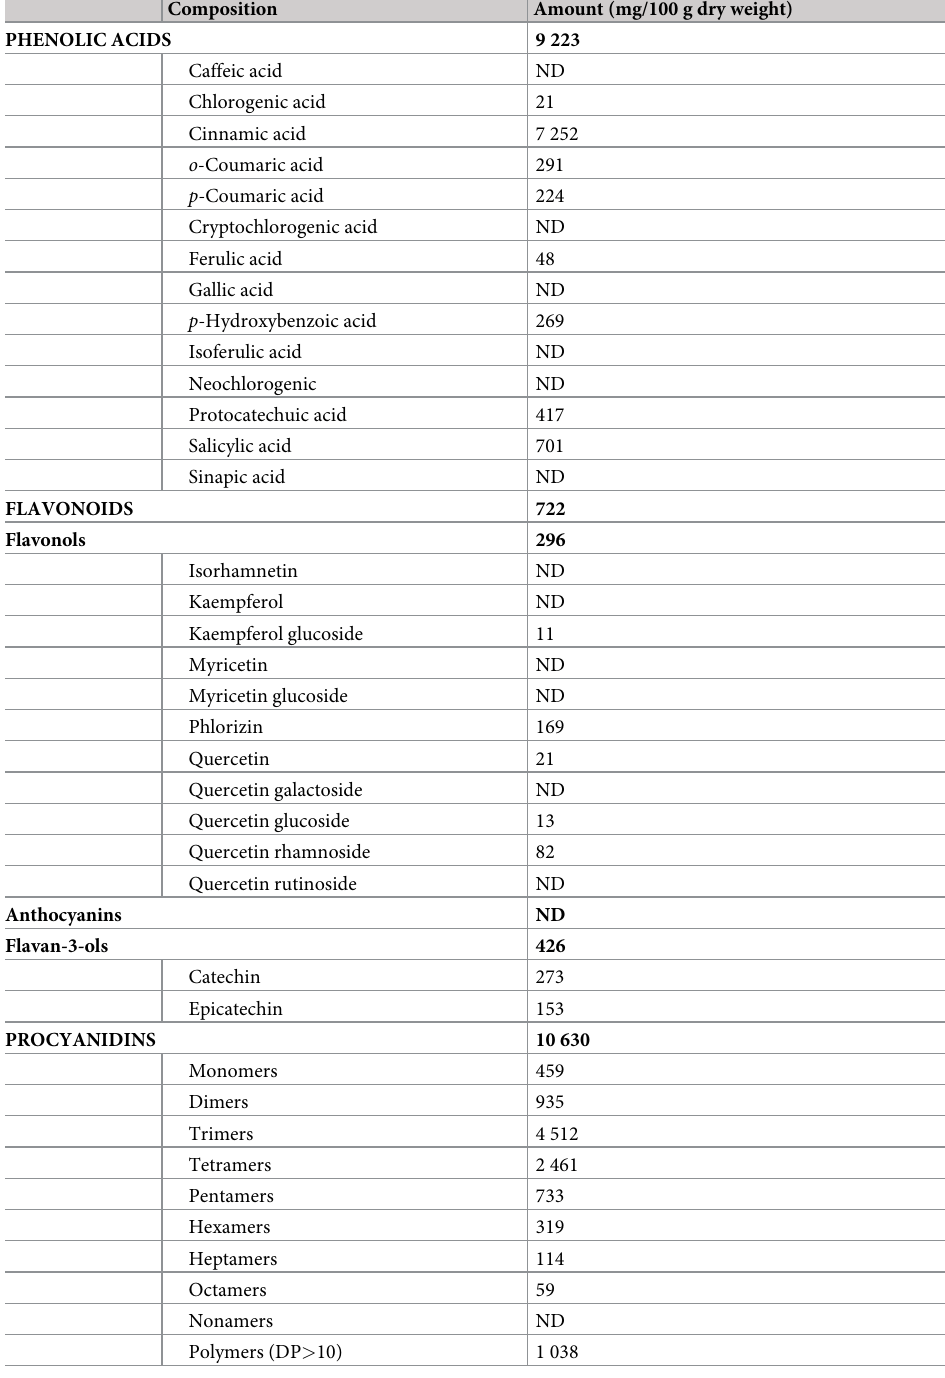
Table 1. Polyphenolic composition of the cinnamon